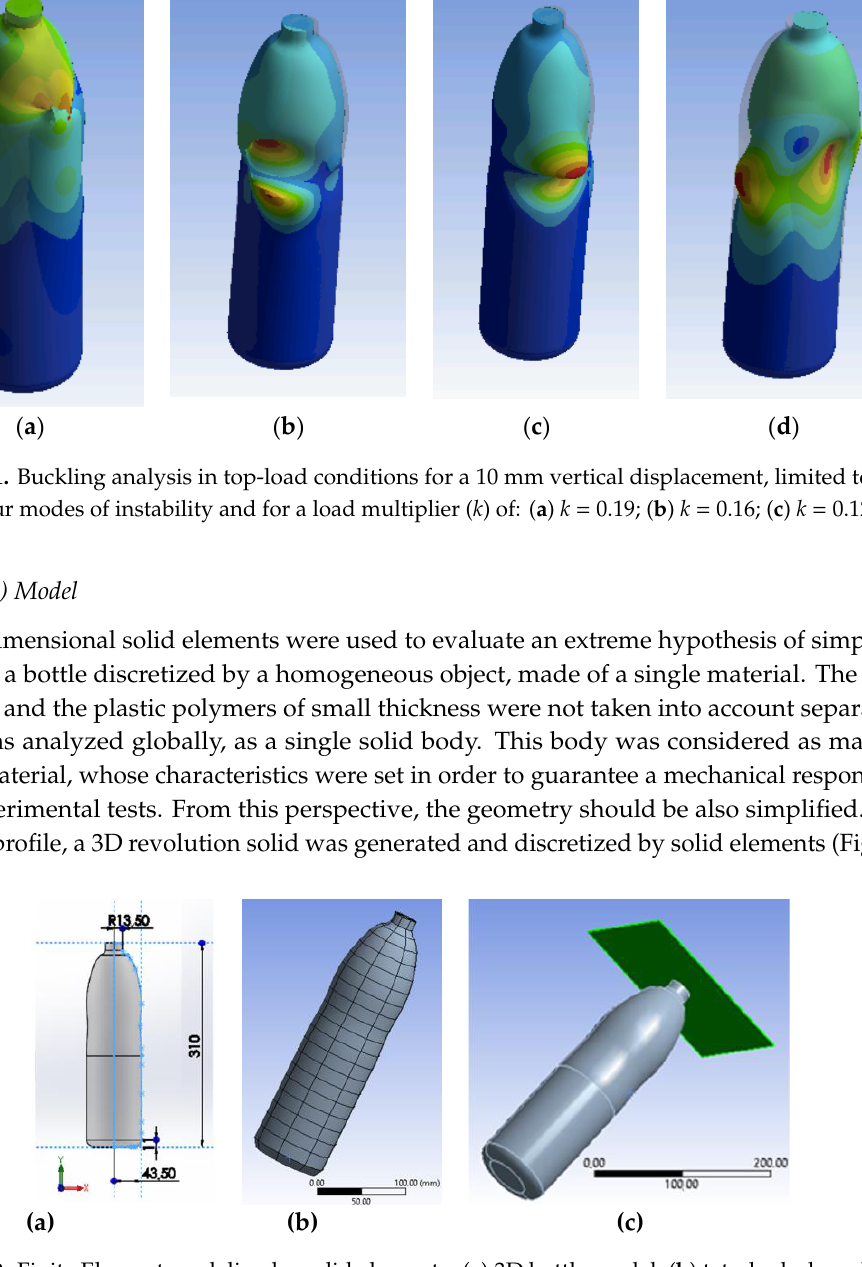
Figure 10. Quasi-static analysis in top-load conditions for a 10 mm vertical displacement: diagram of stress ( a ) and strain ( b ).